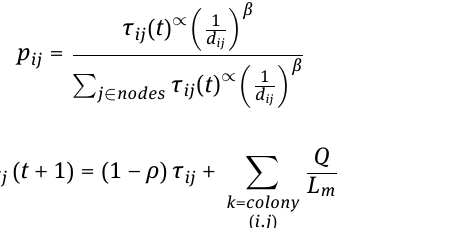
Table 1: Analogy between two systems Natural terms Terms for use in algorithm Natural territory graph (nodes and edges) food source and nest start and destination nodes ants our artificial ants visibility the reciprocal of distance pheromones artificial pheromones foraging behavior Random walk through graph (guided by